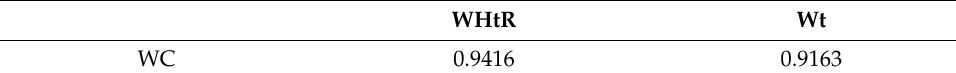
Table 4. Correlation coefficients of WC with WHtR and weight (Wt).